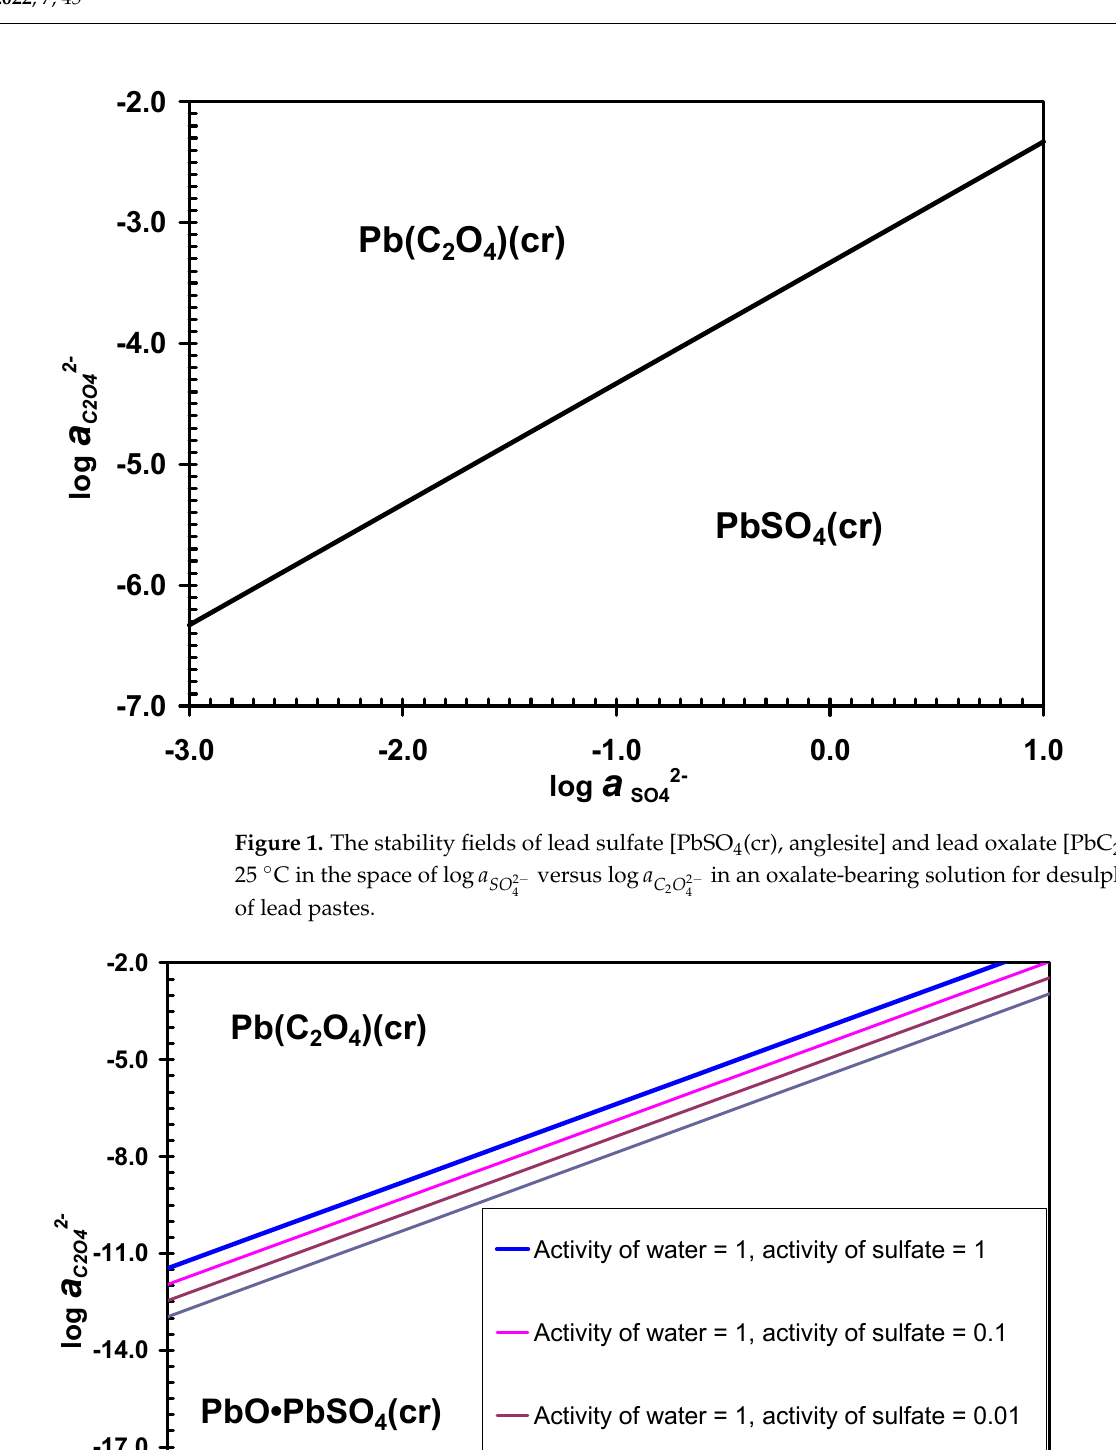
Activity of water = 1, activity of sulfate = 0.001